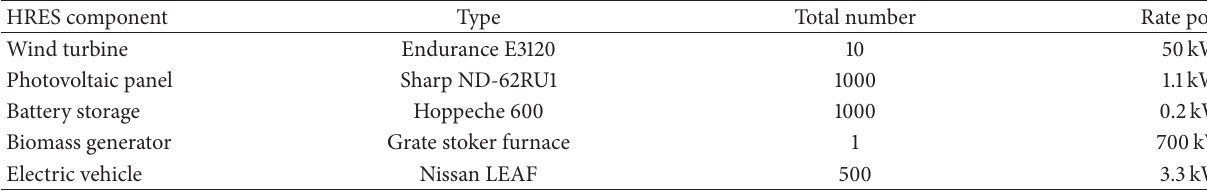
Table 1: HRES components and EV parameters in the microgrid.